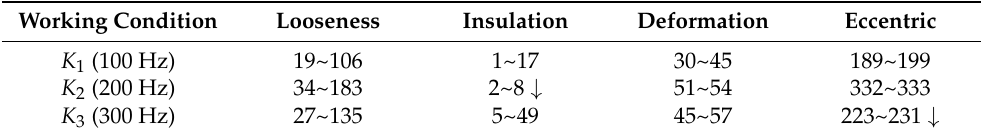
Table 5. Fault characteristic value K i at winding surface point